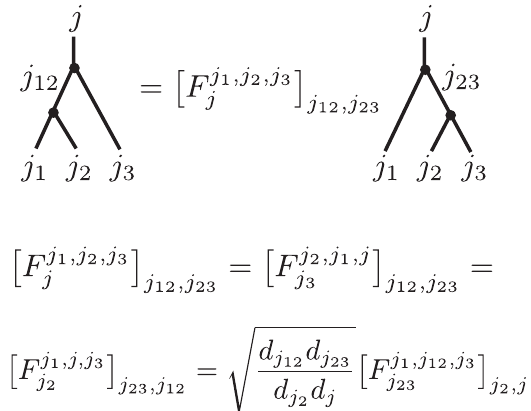
FIG. 2. Graphical definition of the F symbol, together with some identities satisfied by F .